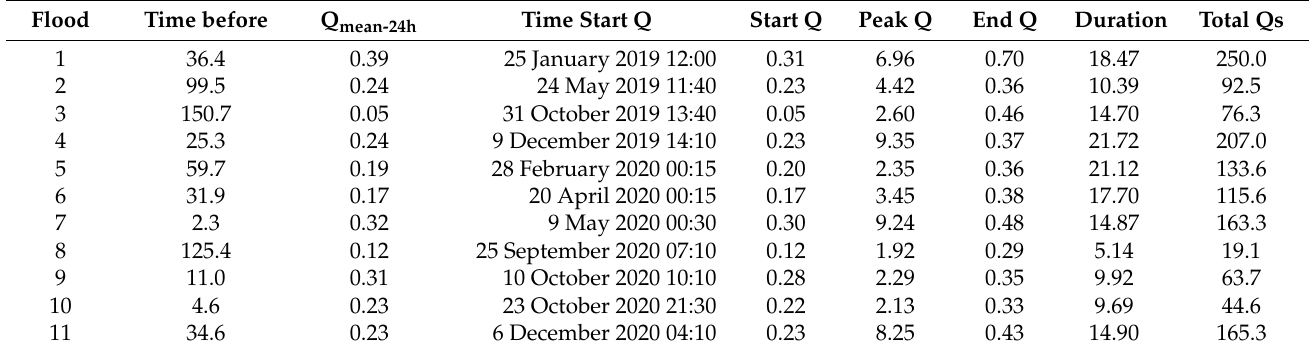
Table 2. Summary of the mean hydrological characteristics for each flood event. Q and Qs refer to discharge (in m 3 · s − 1 ) and specific discharge (in mm). “Time before” refers to the period between the last flood event and the beginning of the current flood event analyzed, “Q mean-24h “ to the average discharge the day before the start of the flood event, “Time start Q” to the date and hour of the beginning of the flood, “Start Q” to the discharge value at the beginning of the flood, “Peak Q” to the discharge value at the peak flow, “End Q” to the discharge value at the end of the flood, “Duration” to the total event, and “Total Qs” to the average specific discharge during the flood. For time and duration, the unit is in